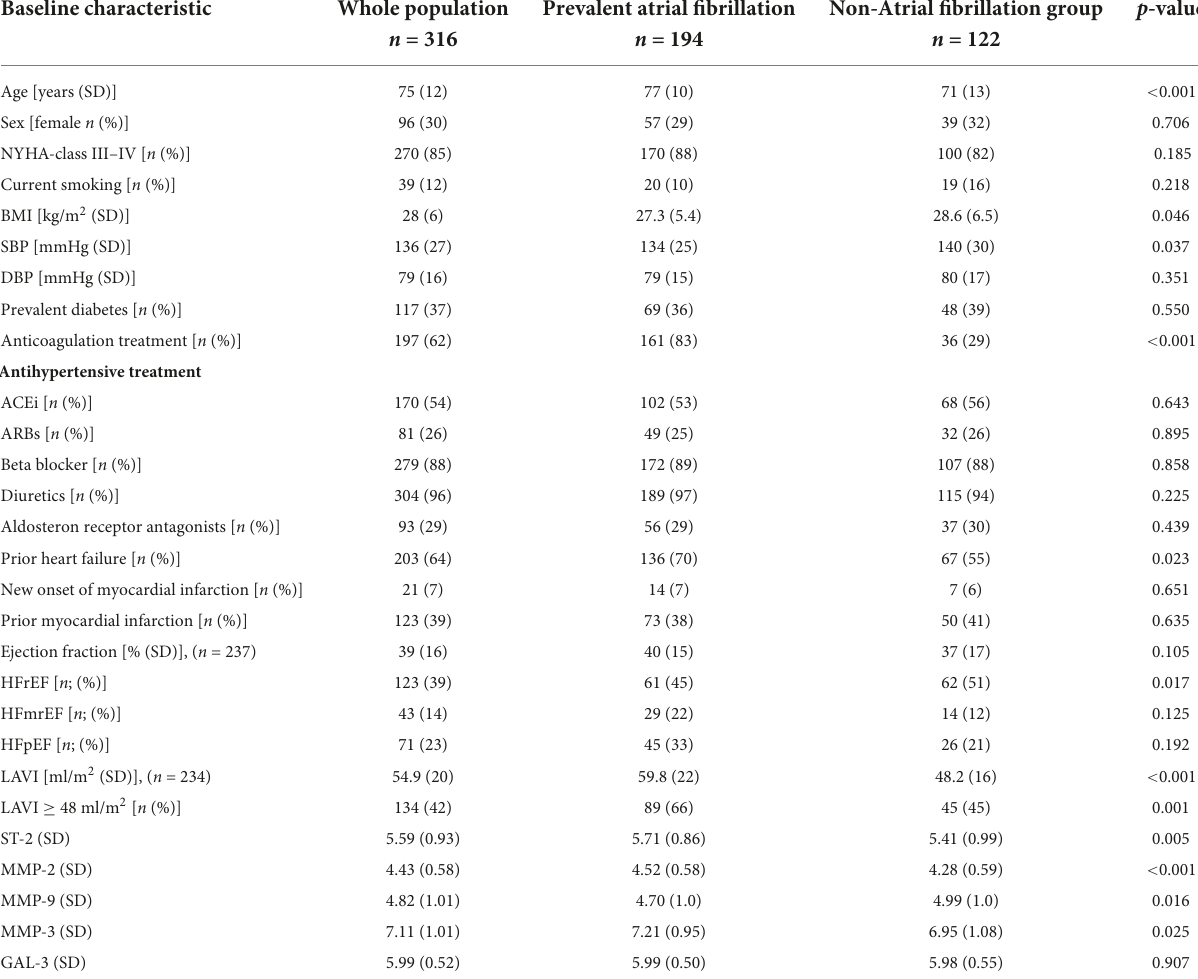
TABLE 1 Characteristics of study participants ( n = 316) at baseline stratified according to the prevalence of atrial fibrillation. Baseline characteristic Whole population Prevalent atrial